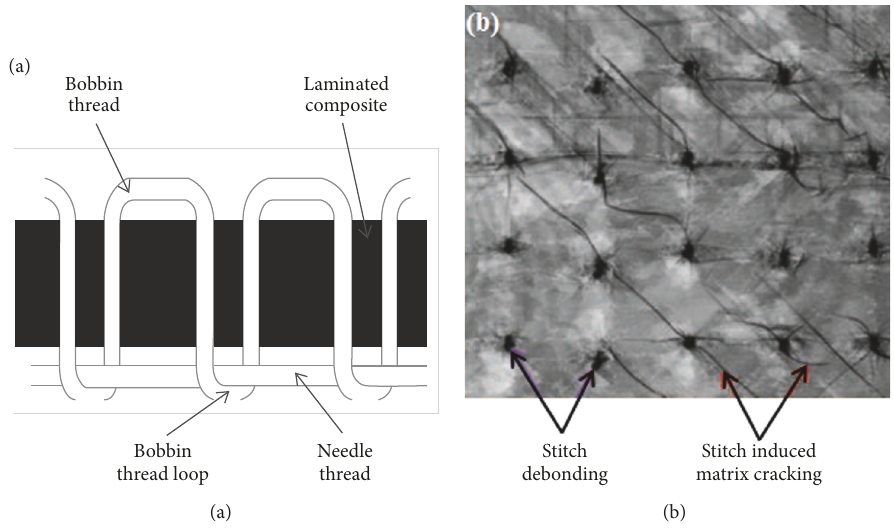
Figure 3: (a) Modified lock stitch. (b) Matrix cracking in stitched laminates